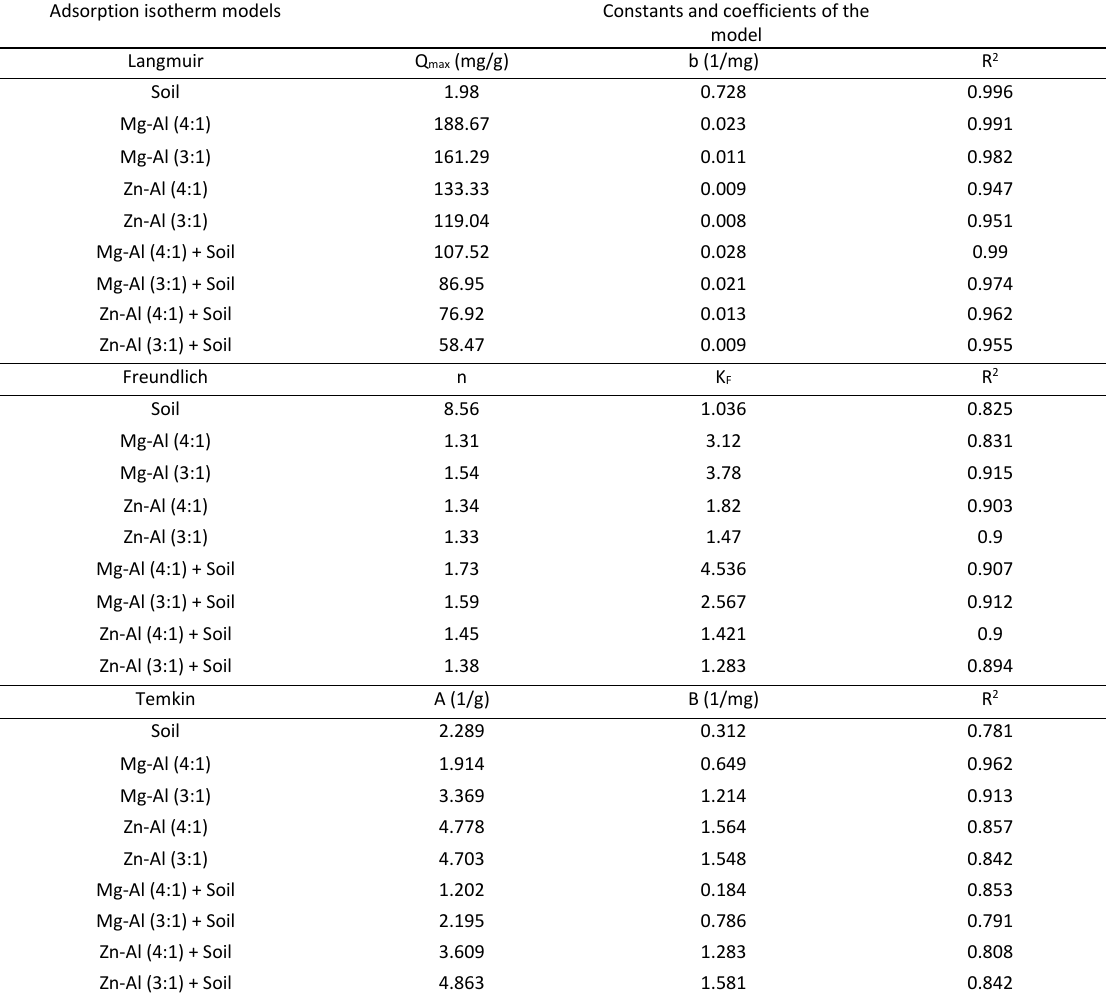
Table 2: Parameters of Langmuir, Freundlich, and Temkin adsorption isotherms, and the correlation coefficients of nitrate adsorption on LDHs Constants and coefficients of the Adsorption isotherm models model